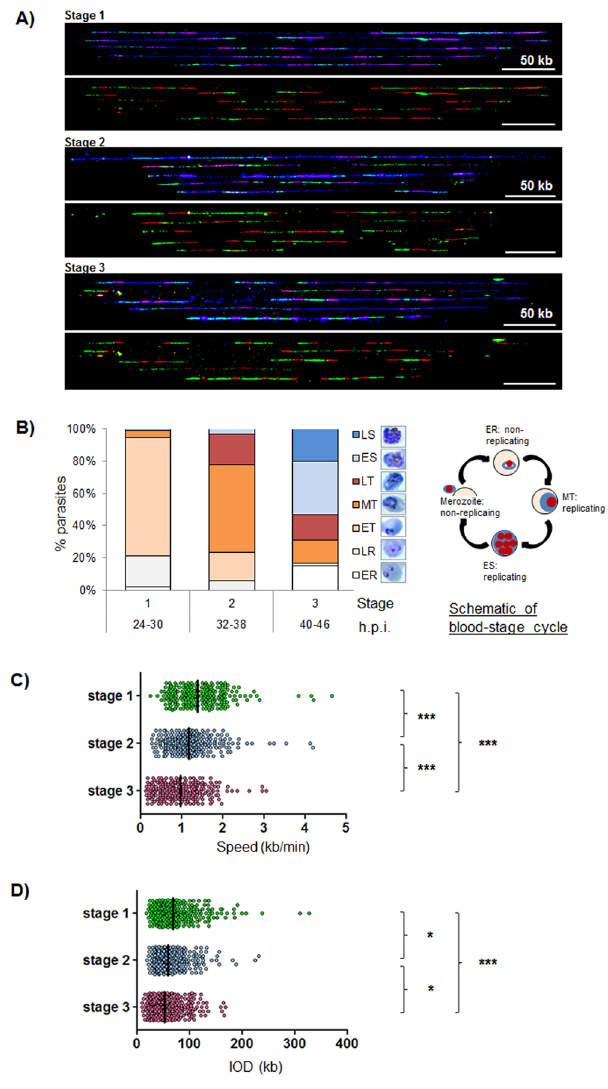
Figure 2. Replication parameters vary across the course of schizogony. ( A ) Representative DNA fibres from synchronous blood-stage parasites at Stages 1–3, labelled as in Fig. 1B. ( B ) Developmental stages of parasites harvested at Stages 1–3. Parasites were classified as: ER small rings, LR large rings, ET early trophozoites (less than half the width of host cell), MT middle trophozoites (more than half the width of, but not entirely filling, host cell), LT late trophozoite (parasite filling all or nearly all of host cell), ES early schizont (discrete nuclear masses visible within parasite), LS late schizont (defined merozoites visible). 100 parasites were counted at each timepoint. The adjacent schematic shows these stages within the erythrocytic replicative cycle. Stage 1 contains predominantly early trophozoites plus some late rings; Stage 2 contains predominantly mid-trophozoites with some early and late trophozoites; Stage 3 contains predominantly early schizonts with some late schizonts and late trophozoites. ( C and D ) Comparative analysis of replication fork speed ( C ) and inter-origin distances ( D ) in synchronous parasites. Black bars on dot plots indicate median values. The two-tailed Mann-Whitney test was used to calculate the corresponding P values ( * P < 0.05; ** P < 0.01; *** P <